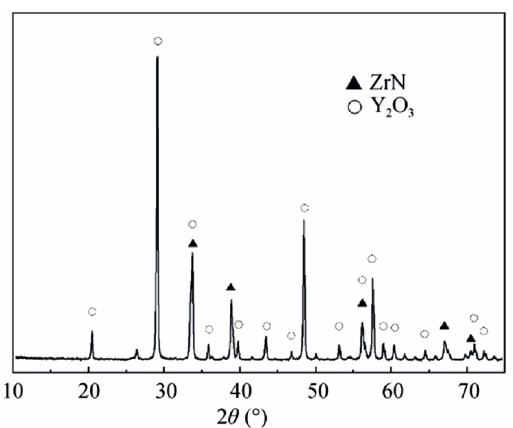
Fig. 2 XRD pattern of the sample with ZrN:Y 2 O 3 = 1:1. Table 1 Phase compositions of the HPed samples